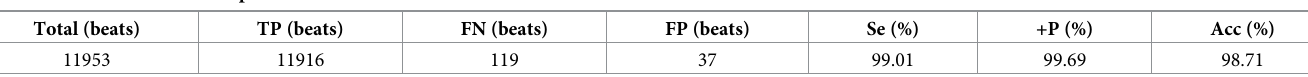
Table 1. Performance of the R peak